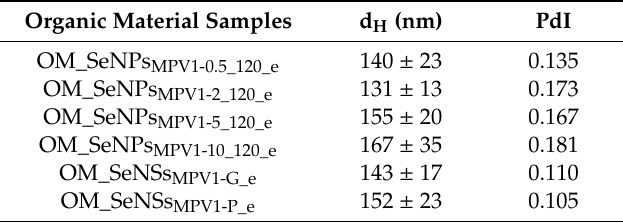
Table 5. Hydrodynamic diameter (d H ) and PdI values of the organic material removed from biogenic SeNSs.